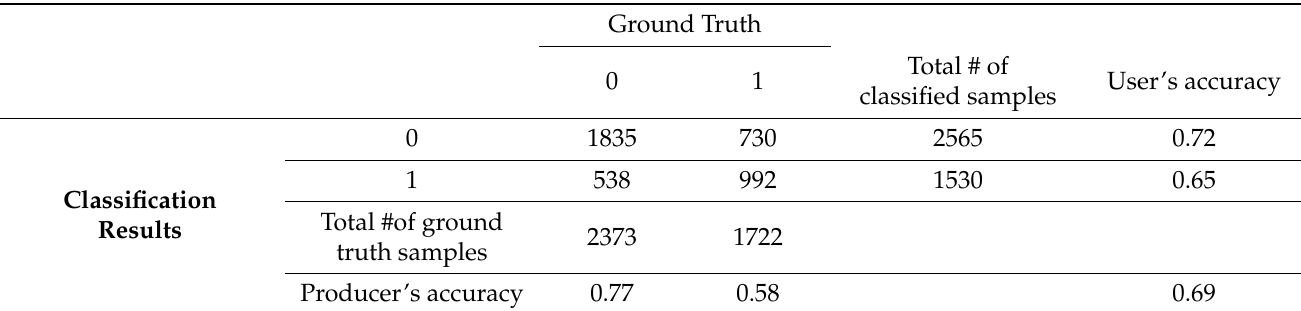
Table 7. Confusion Matrix for X. fastidiosa subsp. pauca severity classes using the non-parametric method with the absolute counts and the accuracies.